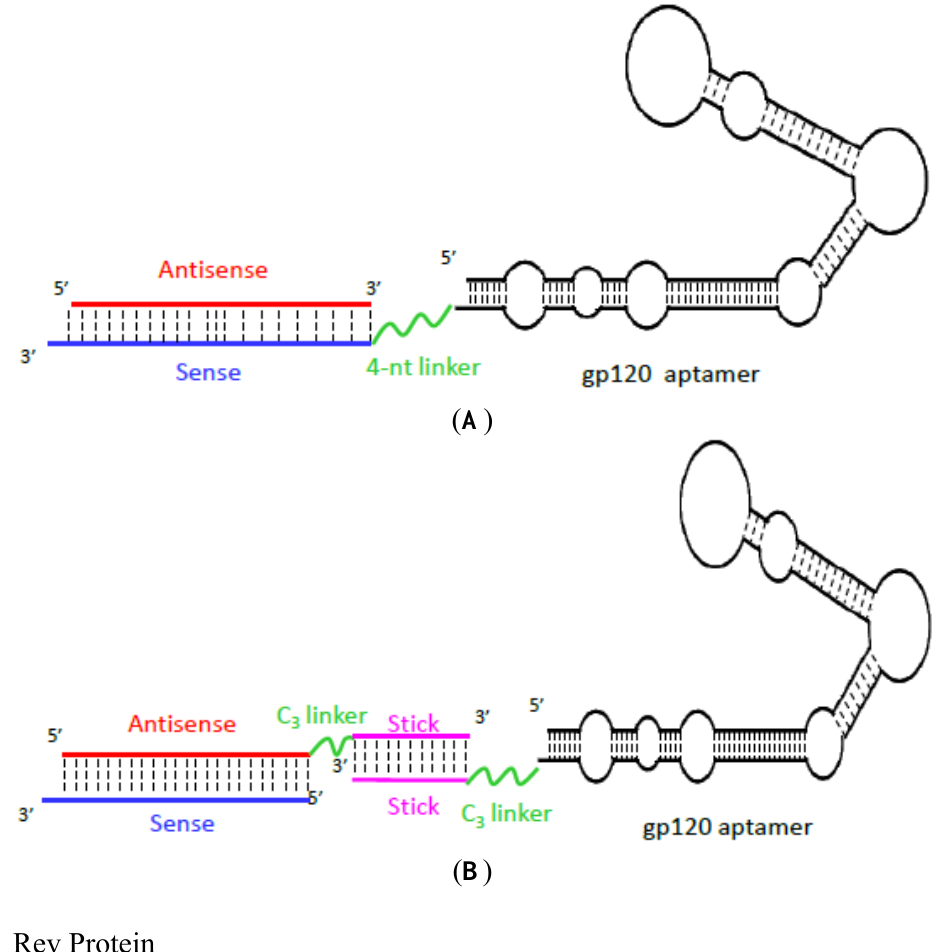
Figure 2. ( A ) Aptamer-siRNA conjugates. The 2'-F-modified gp120 aptamer was covalently appended to the sense strand of a tat/rev siRNA portion, which in turn was hybridized to the antisense strand. A 4-nt linker (CUCU) was inserted between the aptamer and siRNA portions to minimize steric interference of the gp120 aptamer with Dicer processing [143]. ( B ) Aptamer-stick-siRNA chimeras. The 2'-F-modified gp120 aptamer and the siRNAs are shown. The antisense of the siRNA is linked to the aptamer portion by the stick sequence, which consists of 16 nt appended to the 3' end of the gp120 aptamer, allowing complementary base-pairing of one of the two siRNA strands with the aptamers